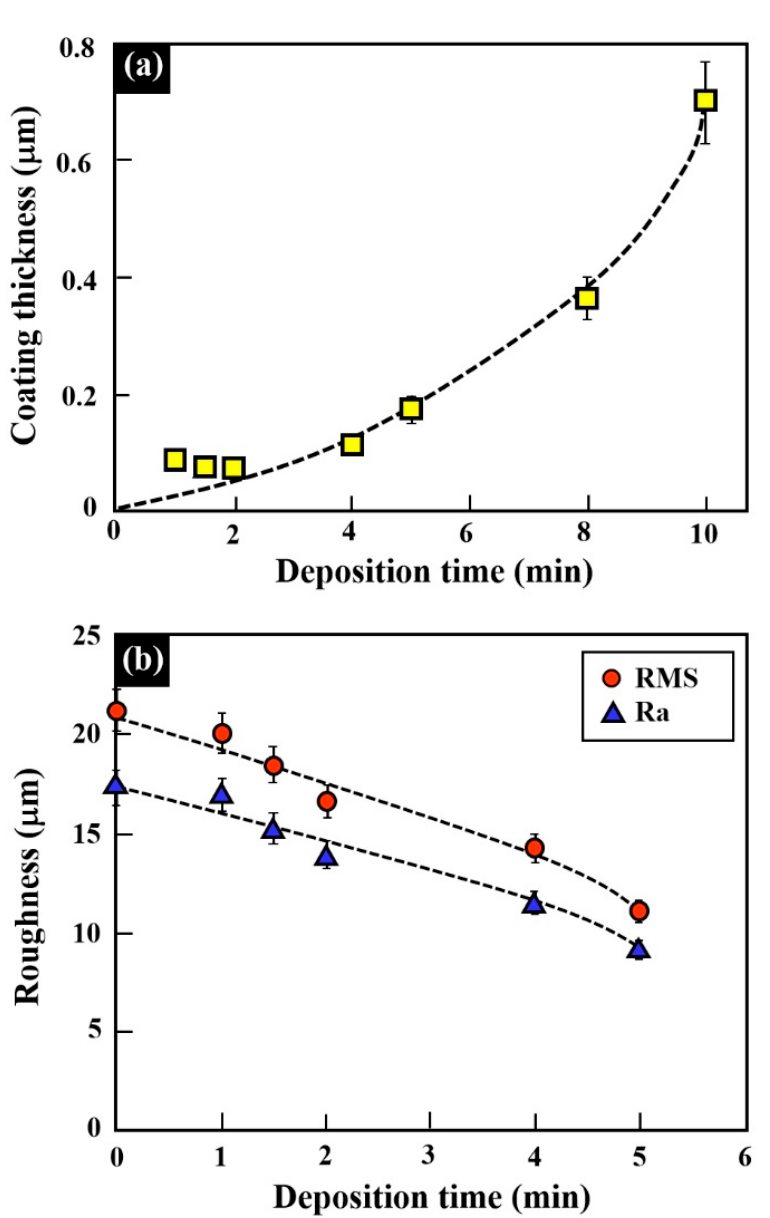
Figure 10. The gold coating on top of AM-LPBF AlSi10Mg printed substrate: ( a ) film thickness as the function of time; and ( b ) the RMS and Ra roughness (measured by profilometer).